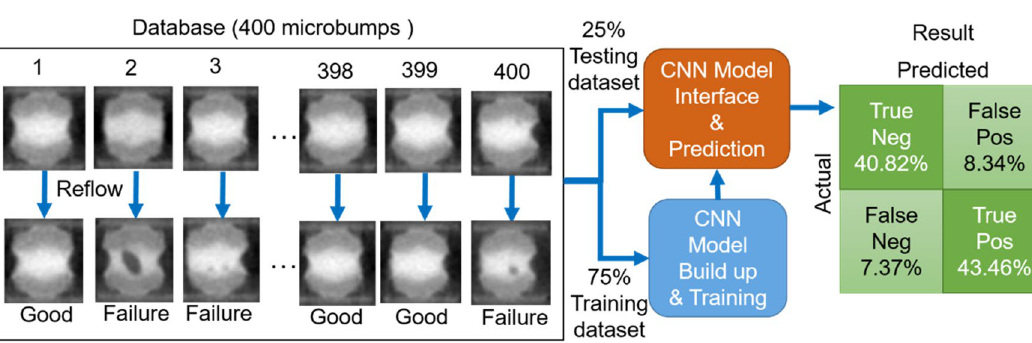
Figure 3. The training/testing procedures and the performance of the CNN